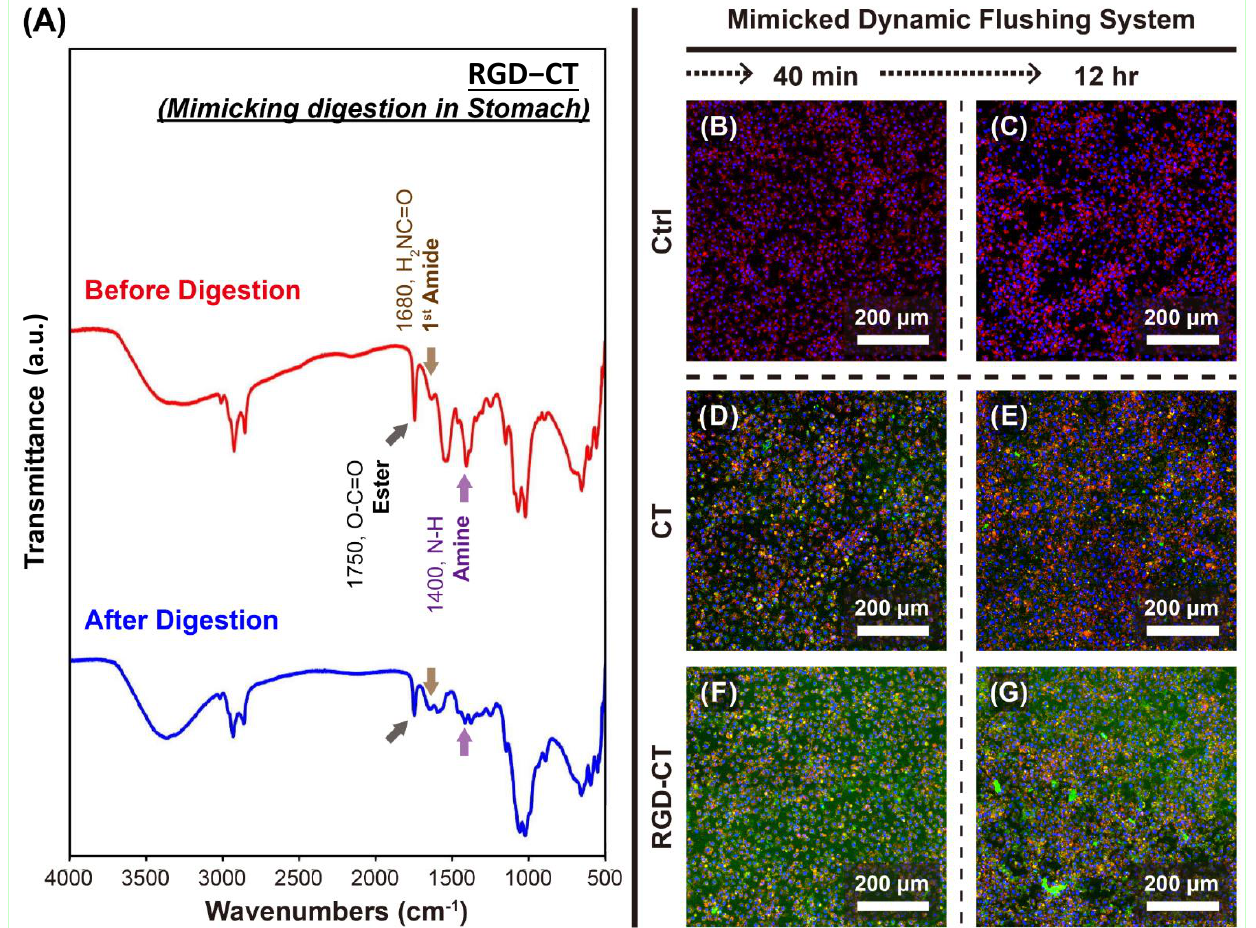
Figure 4. In vitro simulated cell adhesion test. Cell adhesion abilities of chitosan (CT) and RGD − Chitosan conjugate (RC) were tested as described in the methods. ( A ) FTIR analysis of RGT-CT after mimicking digestion. Shown here is the fluorescent staining overlay for ( B ) Control group 40 min, ( C ) Control group ( D ) CT group 40 min, ( E ) CT group 12 h, ( F ) RGD − CT group 40 min, and ( G ) RGD − CT group 12 h. The RGD − CT group shows more material residue compared to the CT group. At 12 h, small fragments of the materials are left.